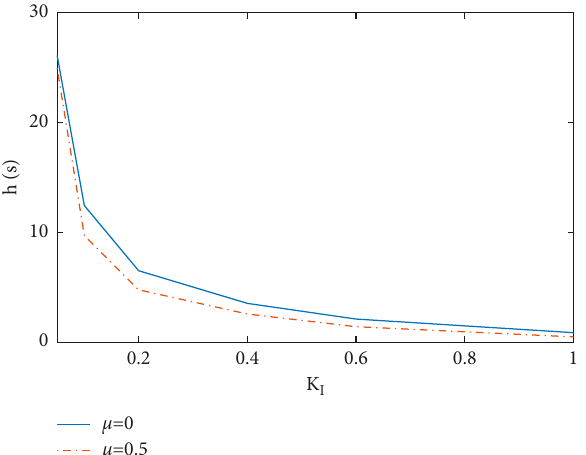
Figure 3: Delay margin h ∝ K